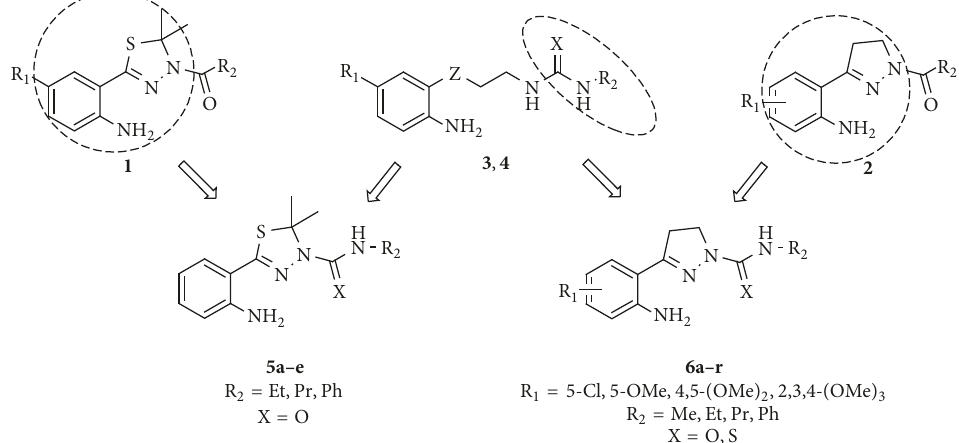
Figure 3: Design strategy and structure of compounds (5a–e) and (6a–r)